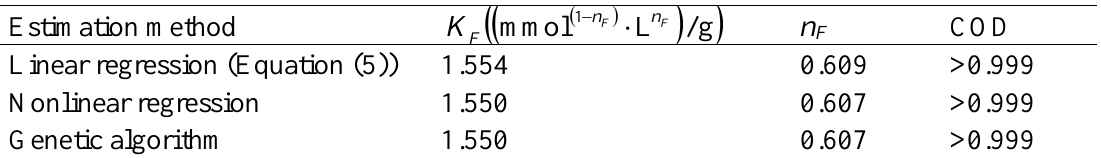
Table 3. Parameter estimation in the Freundlich equation by the linear regression, nonlinear regression and GA